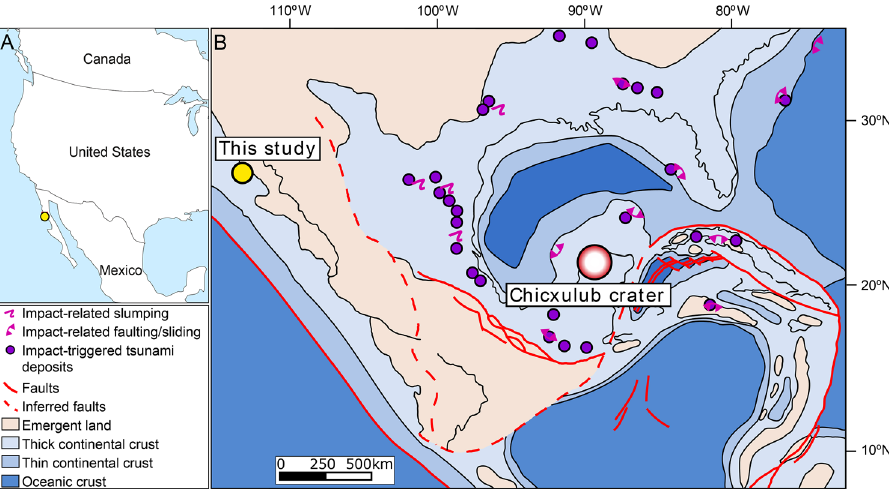
Figure 1. ( A ) location map of the study area (georeferenced and vectorized from Google Earth Pro (2022): https:// www. google. com. br/ earth/ about/ versi ons/), using ArcMap 10.7: https:// www. esri. com/ en- us/ arcgis/ produ cts/ arcgis- deskt op/ resou rces); ( B ) paleogeographic reconstruction of Gulf of Mexico and Baja California Pacific margin taken from Stéphan et al. 18 , and Helenes & Carreño 19 ; using ArcMap 10.7: https:// www. esri. com/ en- us/ arcgis/ produ cts/ arcgis- deskt op/ resou rces), with location of this study, Chicxulub crater, and impact- related slumps, faults, slides, and tsunami deposits (compiled by Vellekoop et al. 20